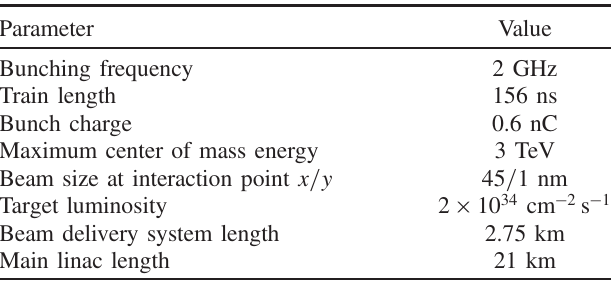
TABLE I. Parameters of the main beams of the Compact Linear Collider